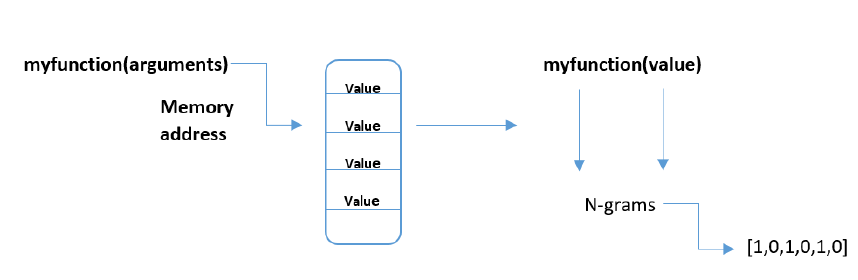
Figure 2. Creation of N-grams for scenario